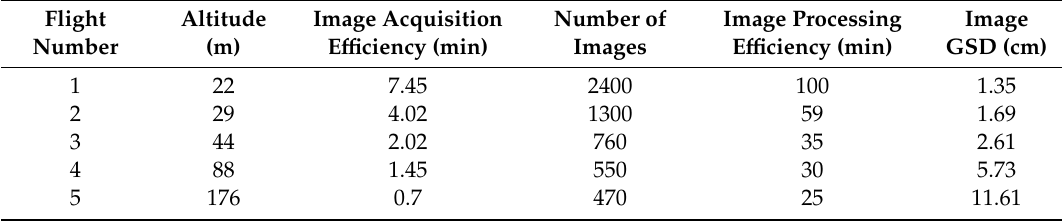
Table 1. Parameters of data acquisition and processing for each flight.